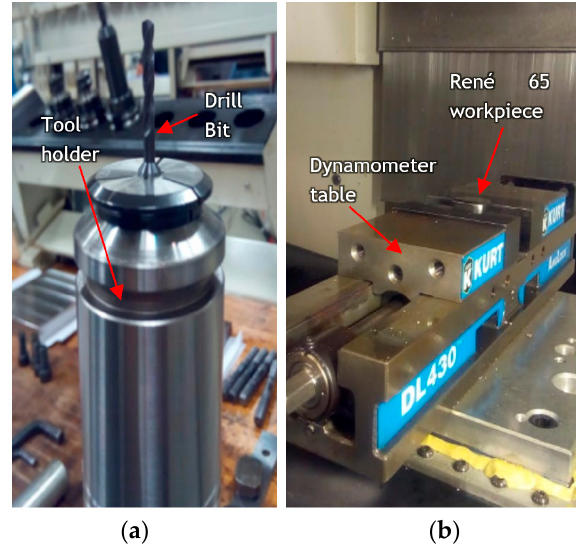
Figure 8. Tool setup: ( a ). Tool and tool holder ( b ). Mounted workpiece on force dynamometer.